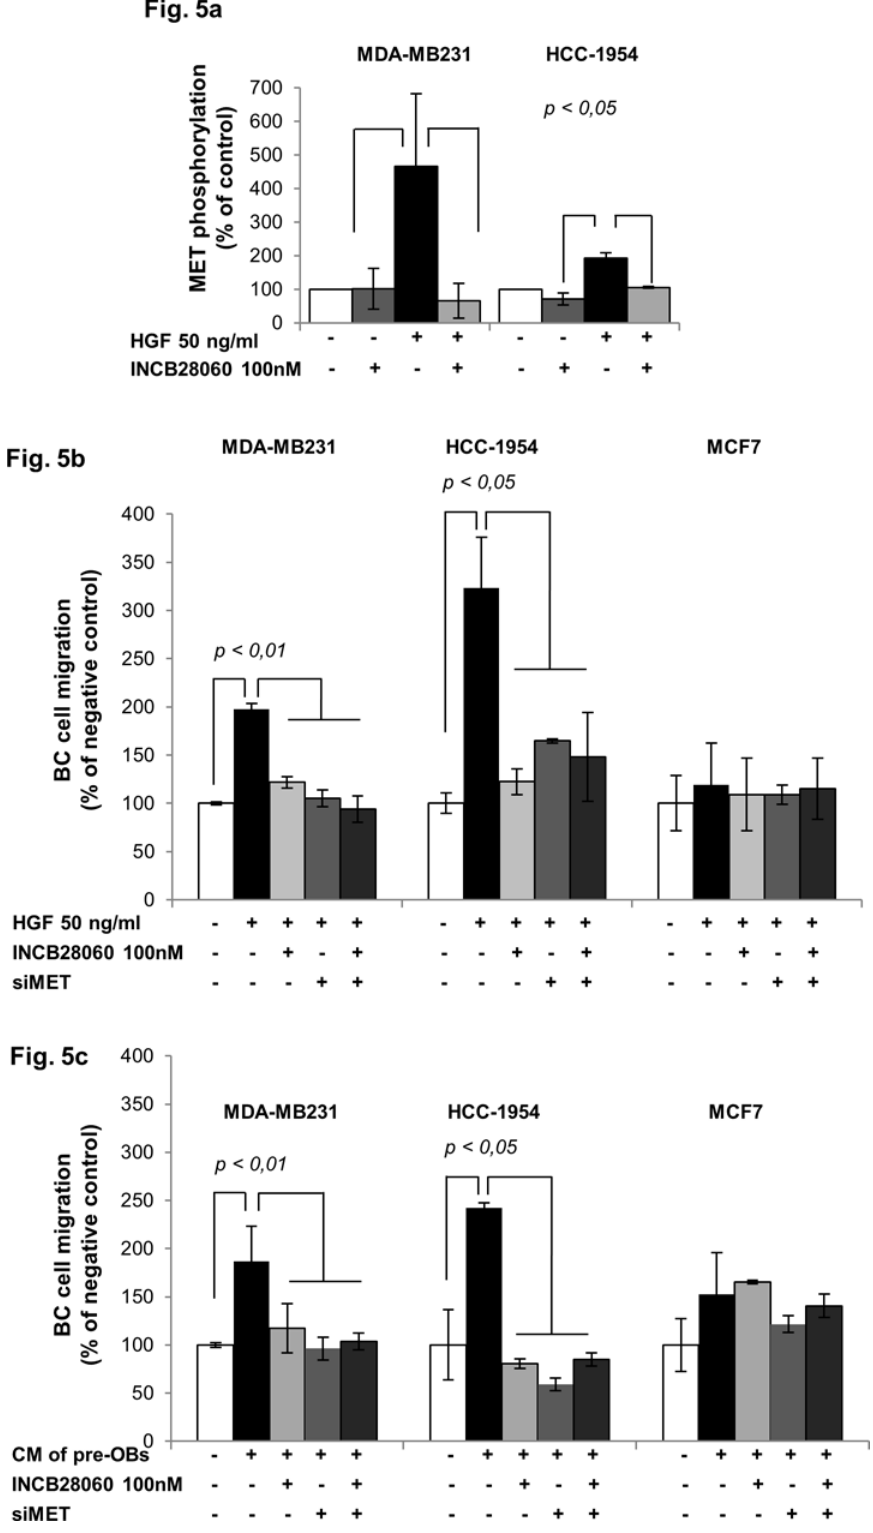
Fig 5. MET inhibition overcomes HGF and pre-OB-induced migration of BC cells. (a) MET inhibition by INCB28060 prevents HGF-induced MET phosphorylation in MDA-MB231 and HCC-1954 cells . After